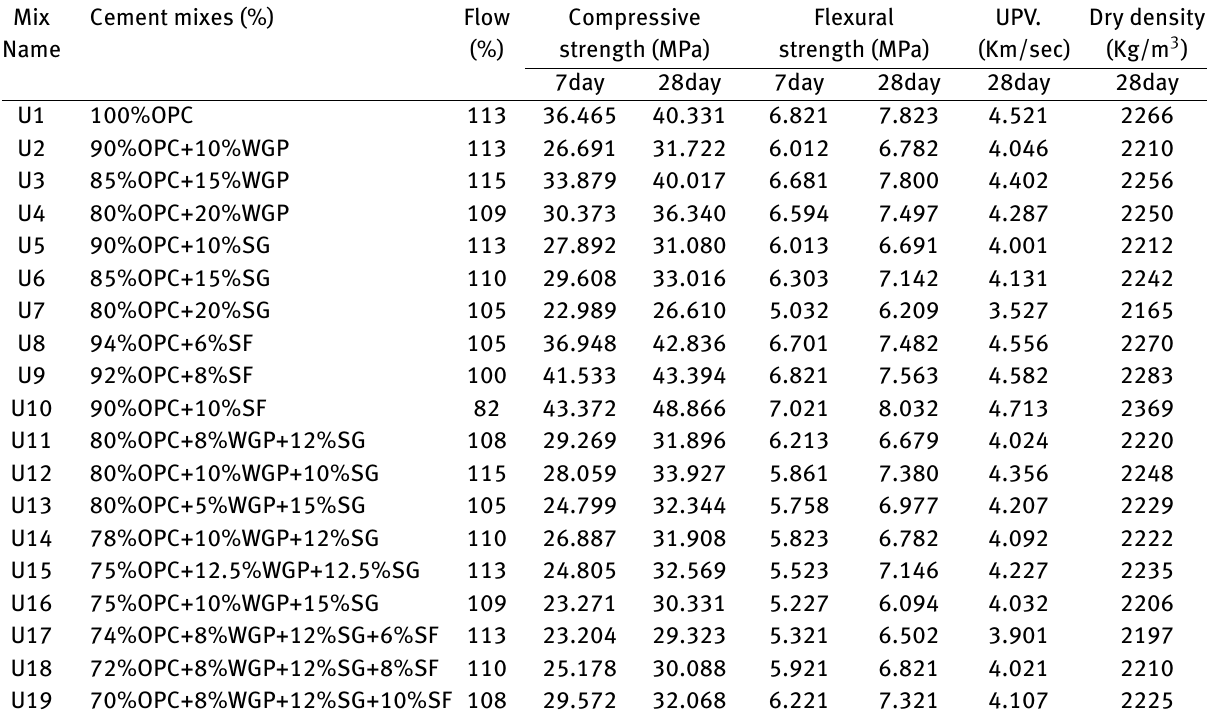
Table 9: Non-reinforced green mortar test results.